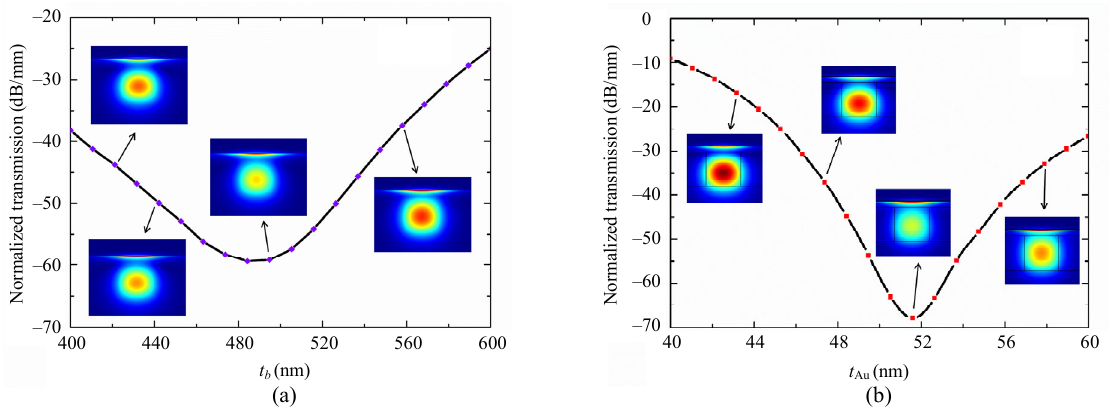
Fig. 5 Normalized transmission changes (a) with the thickness of the PMMA buffer layer and (b) with the thickness of the gold film.